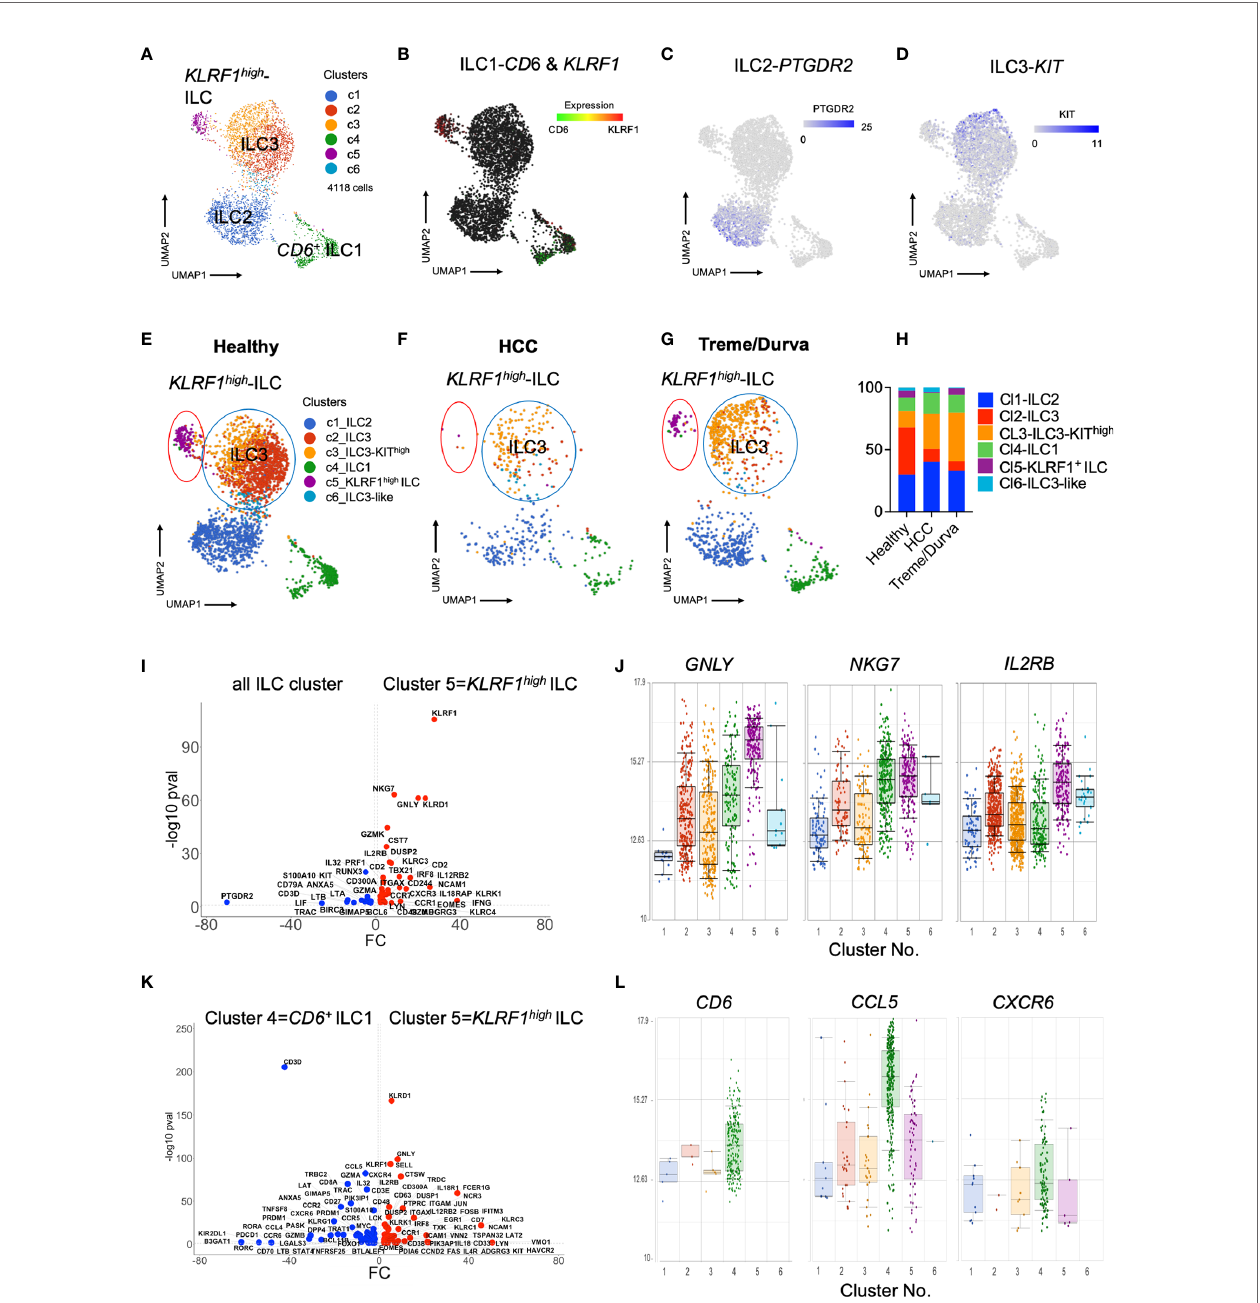
FIGURE 2 | (A) UMAP plot of scRNA-seq data of lin - CD127 + CD161 + ILCs enriched from PBMCs by fl ow cytometry sorting. Merged plot of blood ILCs from nine samples (N = 3 healthy donors, N = 3 HCC patients at baseline, N = 3 HCC patients after ICI with tremelimumab and durvalumab). Unbiased graph-based clustering reveals 6 clusters. Detailed DEGs of clusters are presented in Table 1 . (B – D) Expression of main ILC marker within UMAP plot. (B) Expression of CD6 and KLRF 1 to distinguish two ILC populations. (C) Expression of PTGDR2 to identify ILC2 cluster. (D) Expression of KIT to identify ILC3 cluster. (E – G) Same UMAP plot as in Figure 2A), showing cells split by group. Coloring by graphs-based clustering as in Figure 2A ). (E) UMAP plot of cells from healthy donors (N = 3), (F) UMAP plot of cells from HCC patients at baseline (N = 3). (G) UMAP plot of cells from HCC patients after ICI therapy with tremelimumab and durvalumab (ICI, N = 3). (H) Relative frequency of clusters identi fi ed by graph-based clustering in (A) within all cells of each cohort. (I) Volcano plot of DEGs comparing KLRF1 hig h ILC cluster 5 with all cells. All DEGs passing threshold of FC>2 and p-value<0.05 are plotted. (J) Box plots showing expression of GNLY , NKG7 and IL2RB in the six ILC clusters identi fi ed by scRNA-seq analysis. (K) Volcano plot of DEGs comparing KLRF1 high ILC cluster 5 with CD6 + ILC1 cluster 4. All DEGs passing threshold of FC>2 and p- value<0.05 are plotted. (L) Box plots showing expression of CD6 , CCL5 , and CXCR6 in the six ILC clusters identi fi ed by scRNA-seq